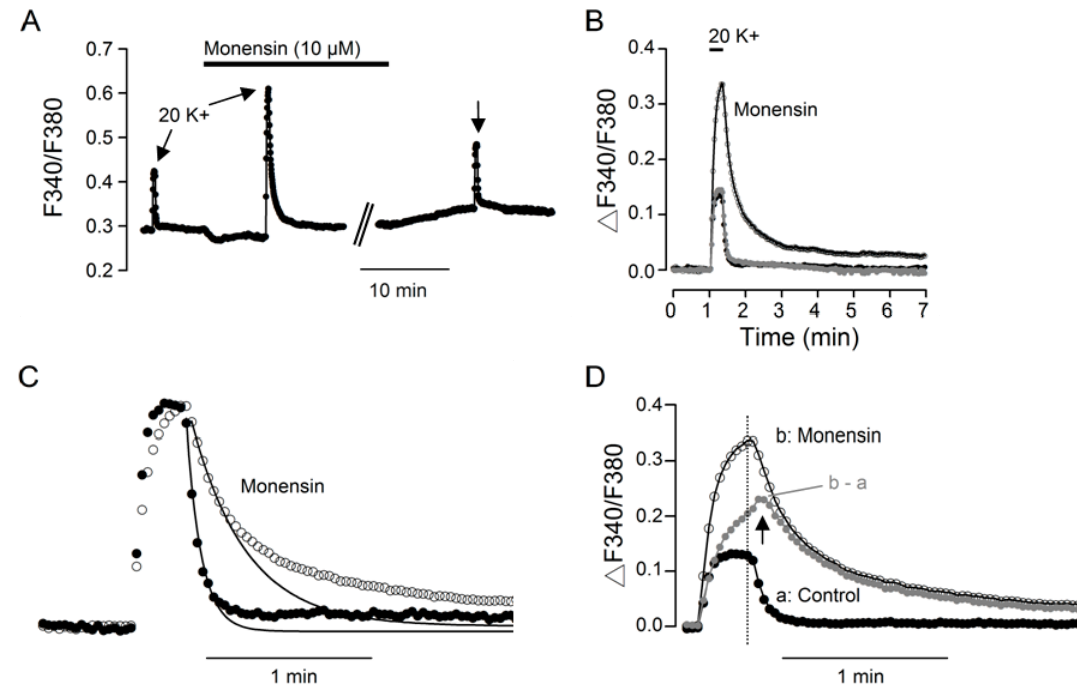
Figure 2. Monensin e ff ects on the 20 K + -evoked Ca 2 + transient. ( A ) A representative experiment showing the reversible e ff ect of 10 µ M monensin on the averaged Ca 2 + response ( n = 13 cells) to 20 mM K + for 20 s. ( B ) Superimposition of Ca 2 + transients evoked before (dark trace), during (open circle trace), and after (grey trace) the application of 10 µ M monensin. ( C ) Normalized Ca 2 + transients in the absence (filled circle trace) and presence (open circle trace) 10 µ M monensin for curve fitting to obtain the fast decay time constants. The smooth curves through the data points were calculated with a fast time constant of 5.4 s and 19.8 s for control and monensin, respectively. ( D ) Superimposition of Ca 2 + transients in control (a, dark filled circle trace) and in the presence of 10 µ M monensin (b, open circle trace), as well as the digitally subtracted monensin-enhanced Ca 2 + transient (b – a, grey filled circle trace). Note the delayed onset of Ca 2 + clearance (marked by arrow) with continuing increase in [Ca 2 + ] i before decay.